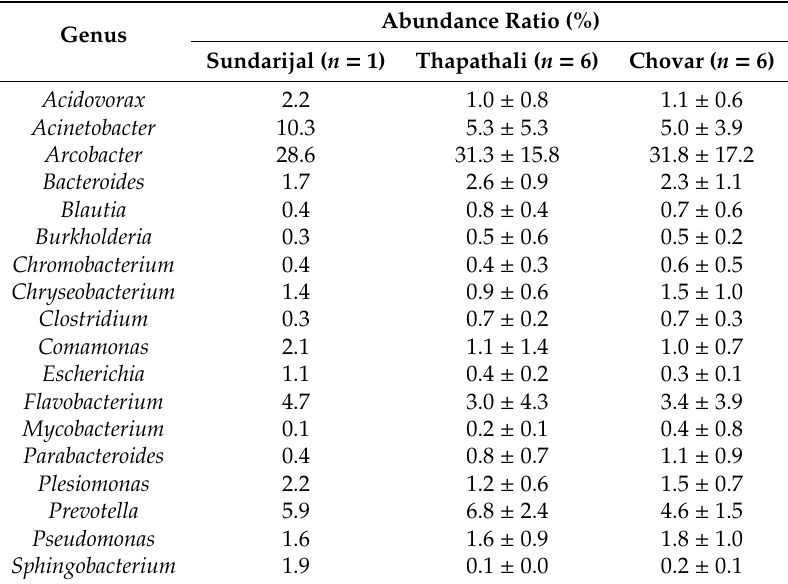
Table 1. Abundance ratios of potential pathogenic bacteria.